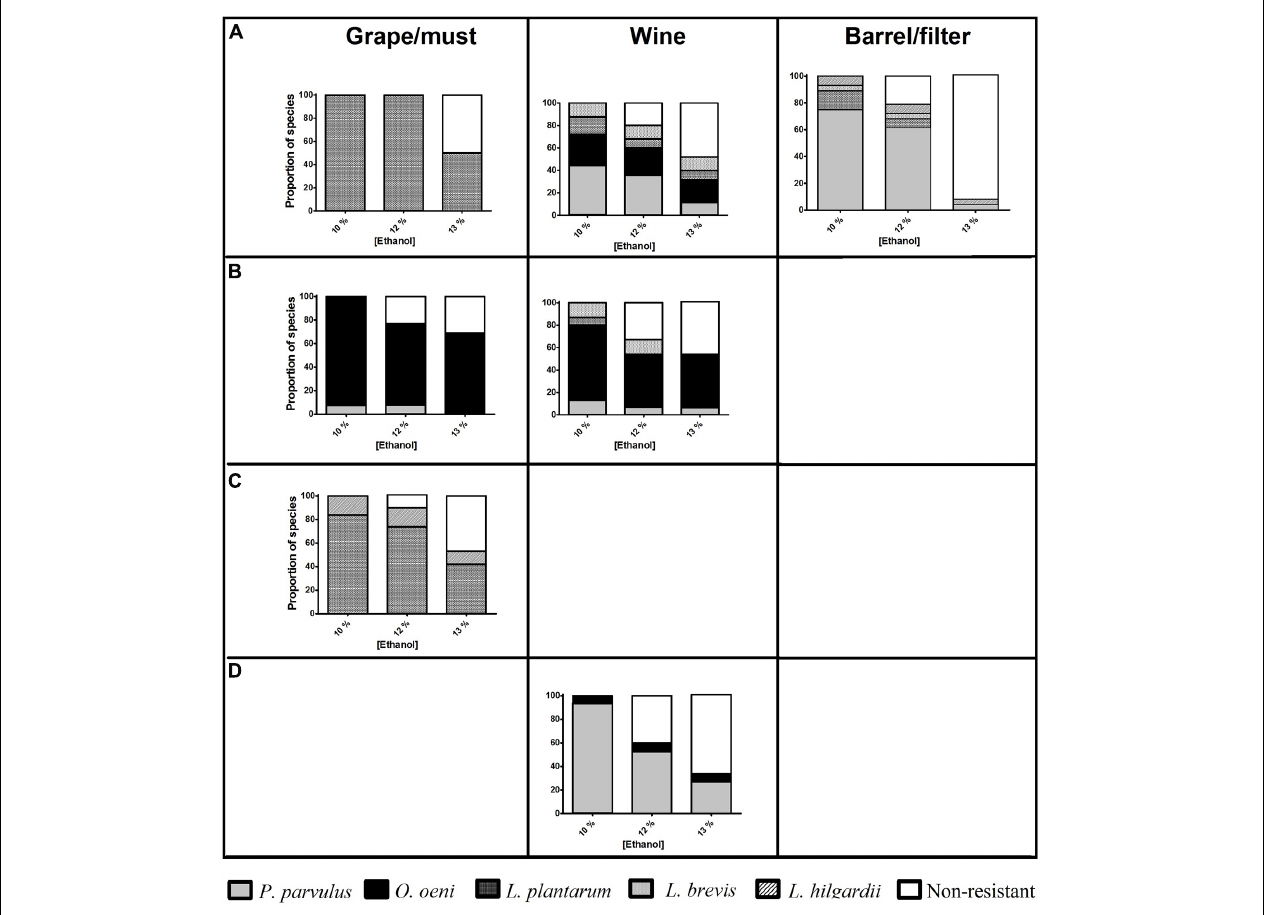
FIGURE 2 | Proportion of isolates of lactic acid bacteria (LAB) species capable of growing in a synthetic medium similar to wine (SW) with SO 2 30 mg l − 1 pH 3.5 and different ethanol concentrations (% v/v, x- axis), from different wineries (horizontal boxes, A–D) and types of samples taken (vertical boxes). The number of resistant isolates is indicated above the